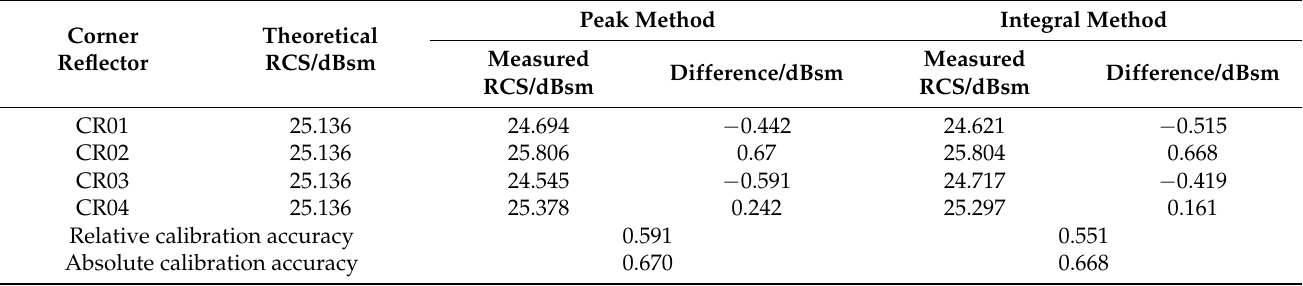
Figure 10. Comparison of the calibration constants and mean values for the VV polarimetric image. According to the principle of radiometric calibration and accuracy evaluation, the average values of the calibration constants calculated via the peak method and the integral method are used as the calibration constant of the whole image for the absolute calibration and the accuracy evaluation of SAR images, respectively. As shown in Table 7, the relative calibration accuracy of the integral method is 0.551 dB and the absolute calibration accuracy is 0.668 dB. For the peak method, the relative calibration accuracy is 0.591 dB and the absolute calibration accuracy is 0.67 dB. The results indicate that the calibration accuracy of the integral method is better than that of the peak method. Table 7. Point target RCS and accuracy analysis based on the peak method and integral